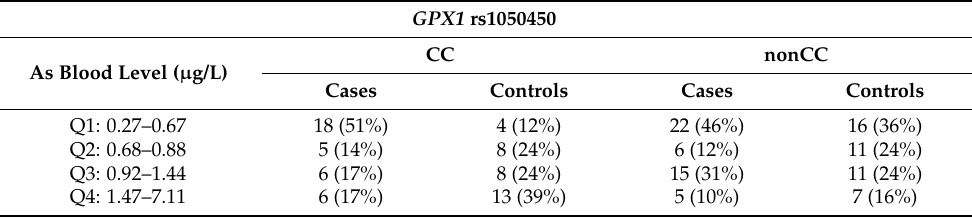
Table 5. Numbers of CRC cases and healthy controls depending on GPX1 gene polymorphism and blood-As concentration in women. GPX1 rs1050450 CC nonCC As Blood Level ( µ g/L) Cases Controls Cases